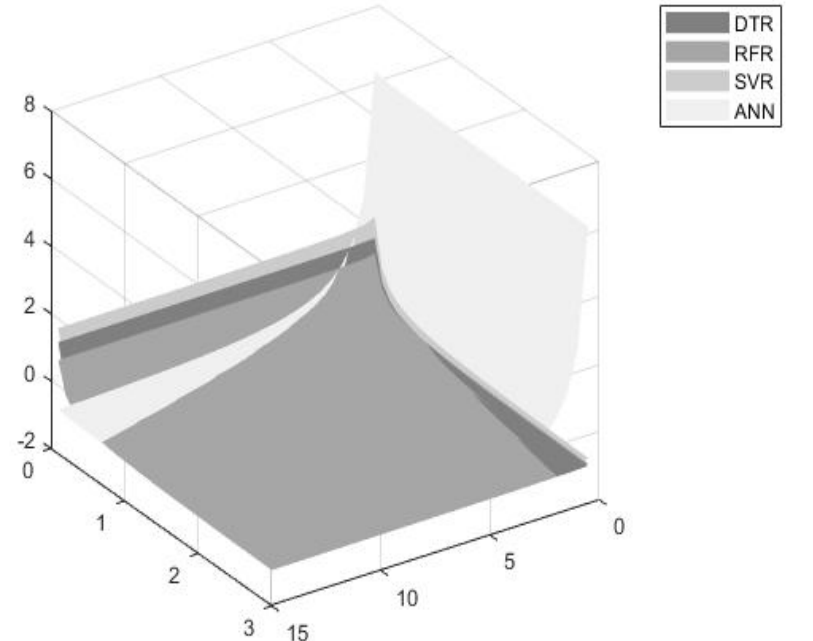
Figure 7. Sensitivity analysis of accuracy and time threshold values with 𝑤 (cid:3028) = 60% , 1- 𝑤 (cid:3028) = 40%